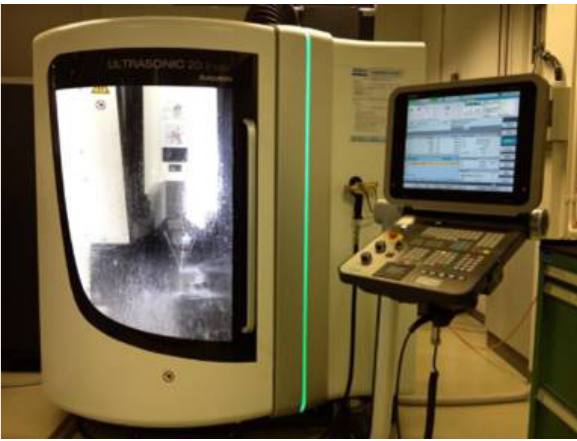
Fig. 4. CNC grinding machine: Ultrasonic 20 linear .